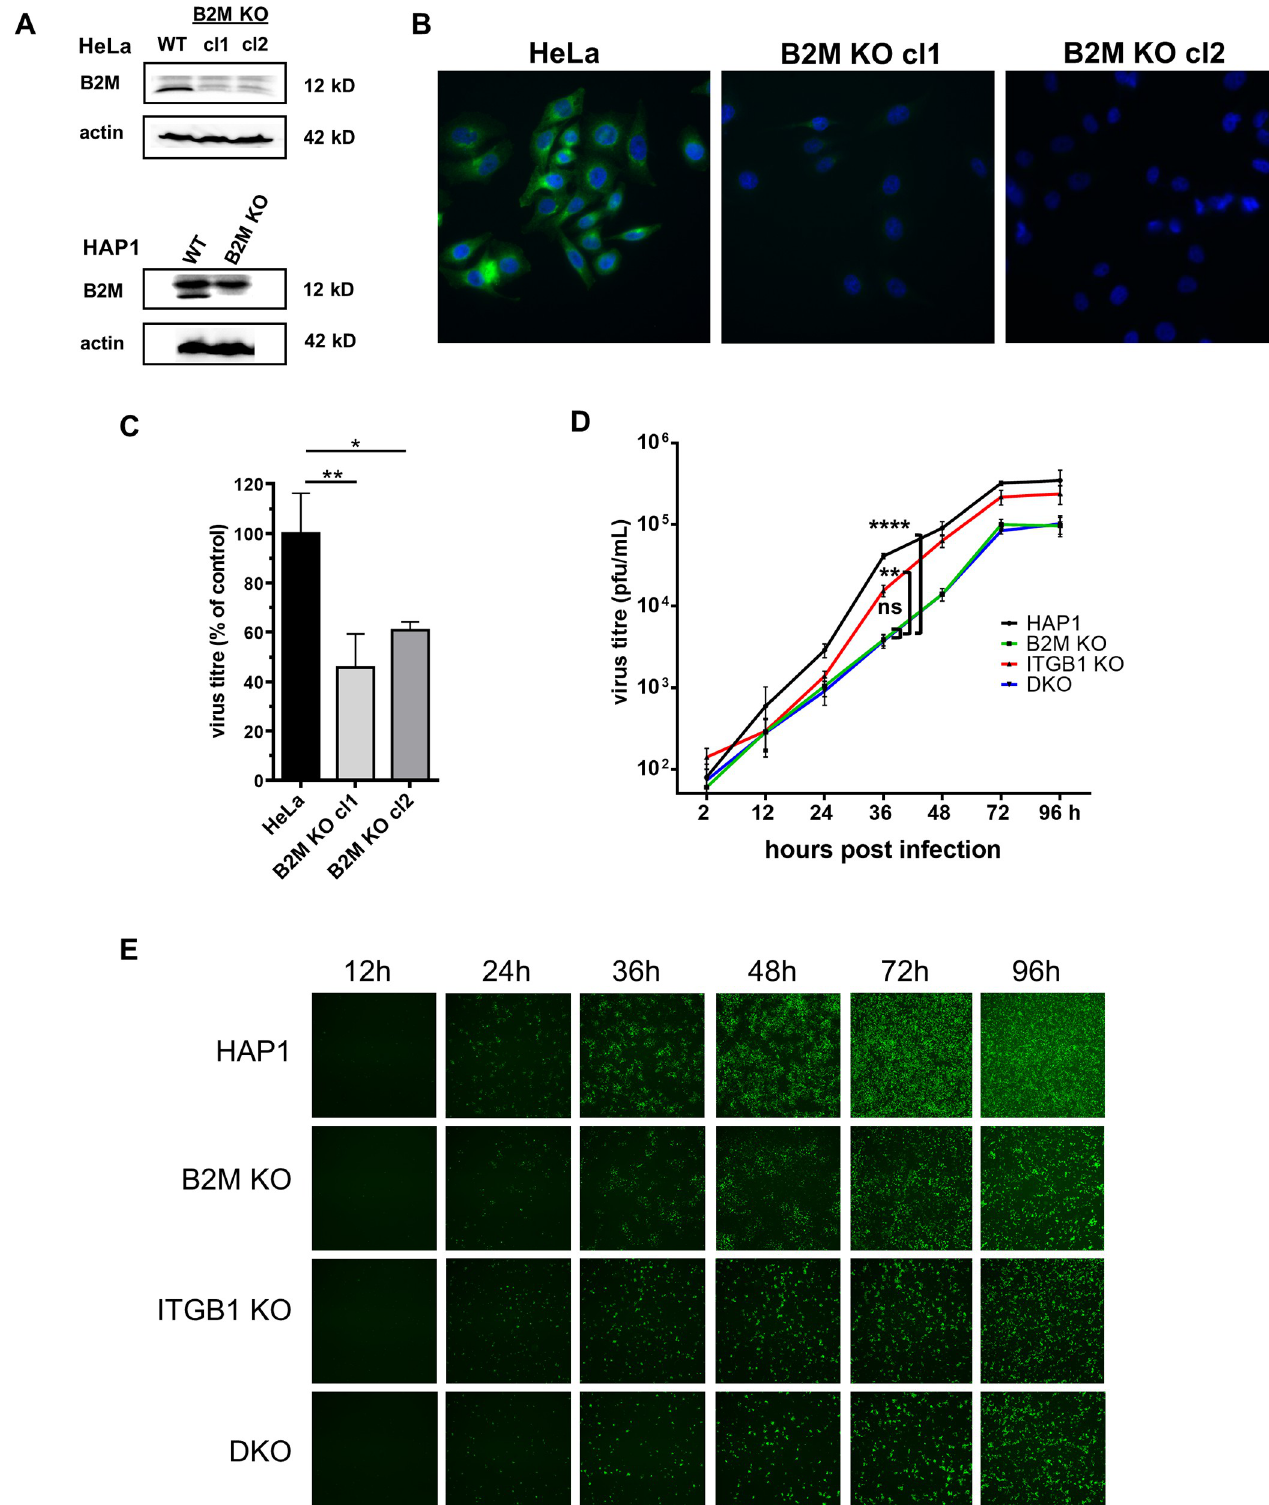
Fig 5. Effect of B2M KO on VV replication. A) Analysis of cell lysates using anti-B2M antibody. B) Immunofluorescence images of HeLa and HeLa-B2M KO cells labelled with anti-B2M antibody. C) Virus production in HeLa and HeLa-B2M KO. Infected cell monolayers (m.o.i. = 0.05) were collected 30 h.p.i.